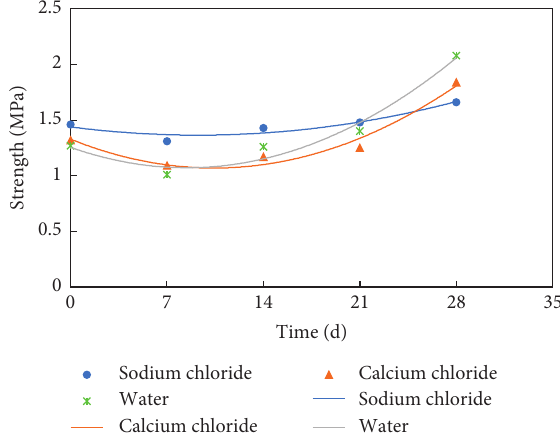
Figure 14: Peak compressive strength of the cylindrical specimen of HWC materials after erosion in different